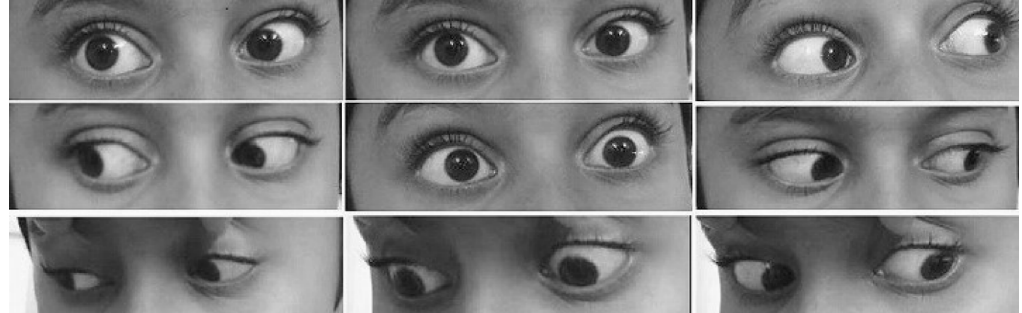
Figure 1: Position of the patient’s eyes in all the gazes at the time of presentation showing significantly restricted ocular movement in upgaze and mild restriction in downgaze